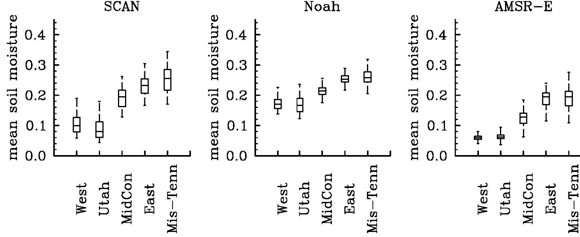
Fig. 2. Box plot of daily mean soil moisture (cm 3 cm − 3 ) in climate regions and sub-regions for the three data types. Statistics of Noah and AMSR-E were calculated using data at SCAN